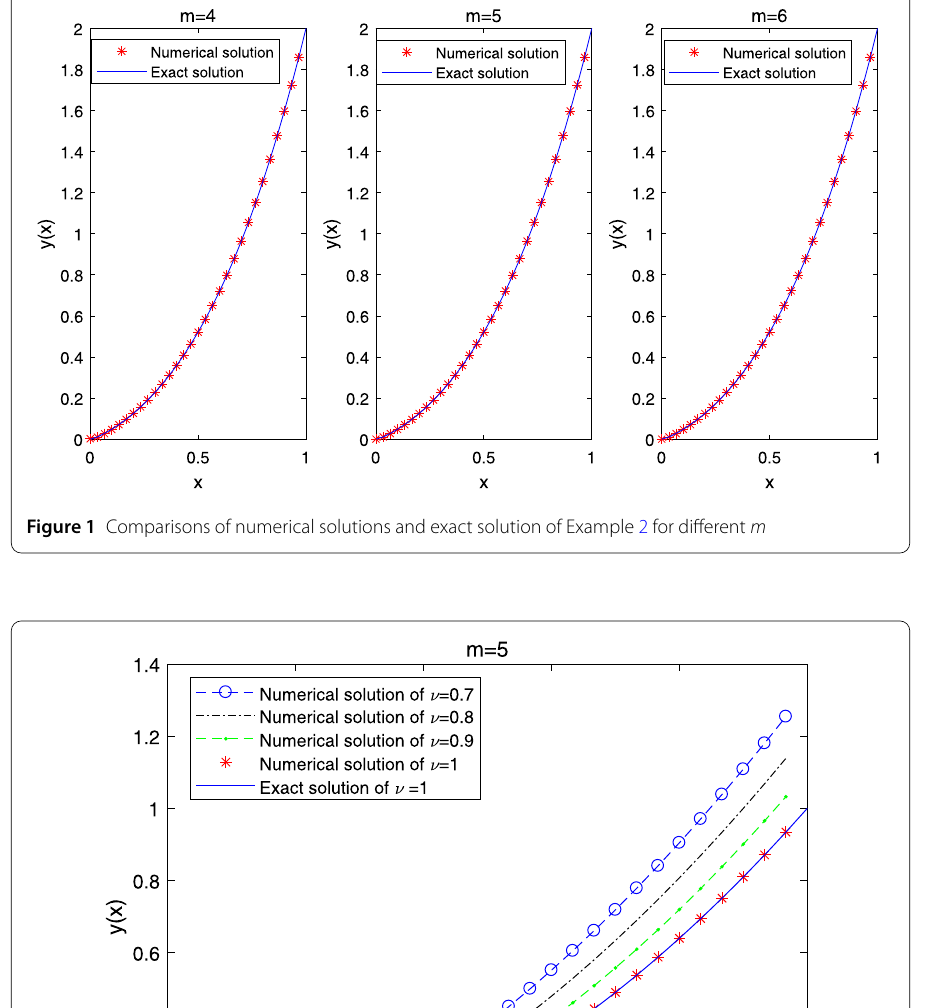
x 1 2 with the condition y (0) = 0. The exact solution is y ( x ) = x 2 where f ( x ) = 2 x , p ( x ) = – 16 15 when ν = 1. By setting m = 5, we obtain numerical solutions for various values of α = ν . In Fig. 2, we show the numerical solutions obtained by the presented method and the exact solution for various values of ν = α . It is obvious from Fig. 2 that, as ν is close to 1, the numerical solutions converge to the exact solution. Table 4 shows the root-mean- square errors for the second kind Chebyshev polynomials method (SKCP) [40] and the FEFs method for α = 1 with different m . From Table 4, we can see that the errors decay